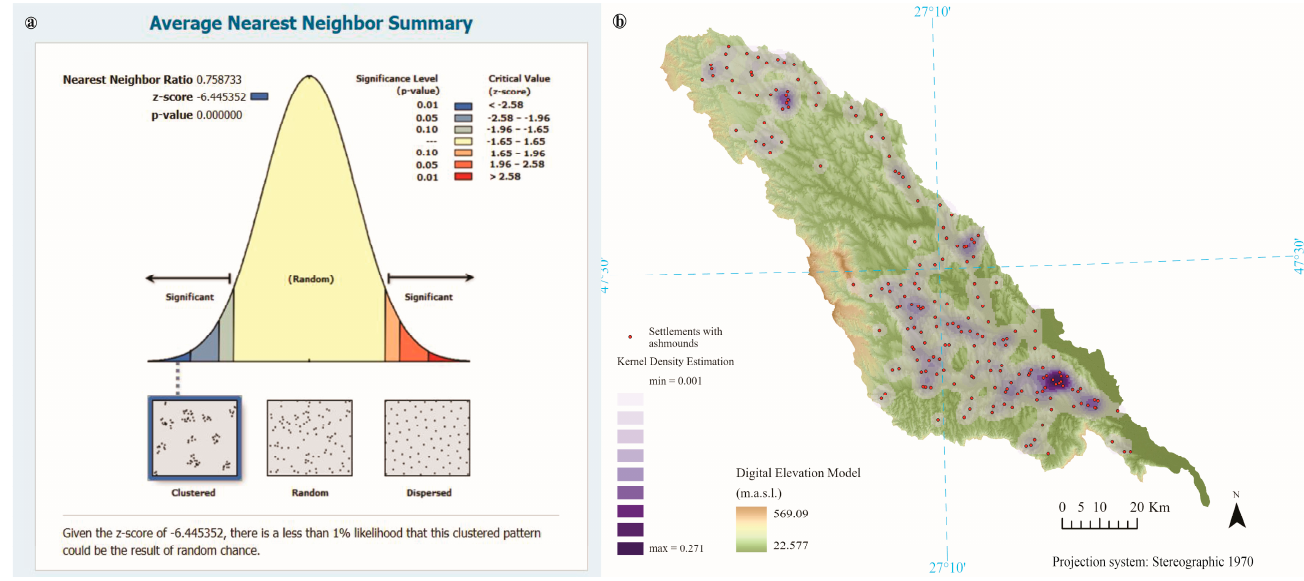
Figure 11. ( a ) The summary of the Nearest Neighbor analysis; ( b ) map representing the results of Kernel Density Estimation analysis.